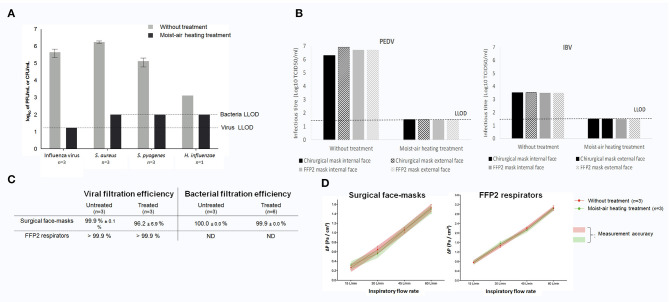
(A) Decontamination yields obtained after dry- or moist-air heating treatment for influenza A H3N2/Scotland/20/74 virus and oropharyngeal bacteria. (B) Decontamination yields obtained after moist-air heating treatment for swine porcine epidemic diarrhea virus [(PEDV) left panel] and avian infectious bronchitis virus of chicken [(IBV) right panel] coronaviruses. Lack of virus re-isolation was arbitrarily indicated in the figure as a titer equal to the lower limit of detection (LLOD) of the re-isolation process. (C) Filtration properties of surgical masks (upper panel) and filtering face piece type 2 (FFP2) respirators (lower panel) for the influenza A H3N2/Scotland/20/74 virus strain and for Staphylococcus aureus ATCC 6538 (on surgical masks only for the latter as specified by EN 14683 guidelines). (D) Measurement of inspiratory resistance for surgical masks (left panel) and FFP2 respirators (right panel). All results are expressed as mean ± SEM. CFU, colony-forming unit; ΔP, differential of pressure; L/min, liter per minute; ND, not determined; Pa/cm2, Pascal per square centimeter; PFU, particle-forming unit; SEM, standard error of the mean.